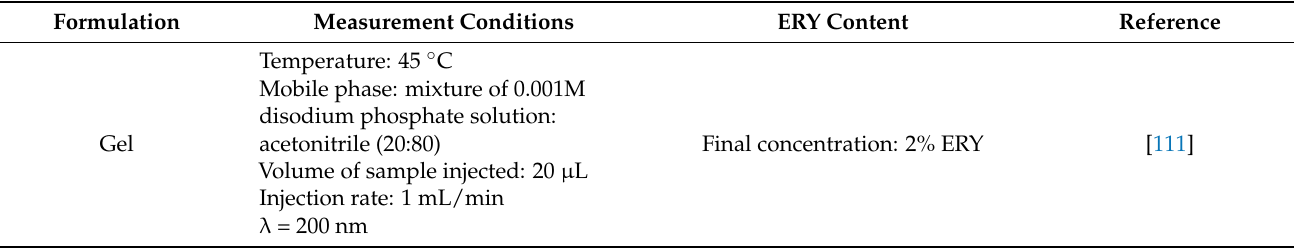
Table 3. ERY quantification procedures by HPLC in the